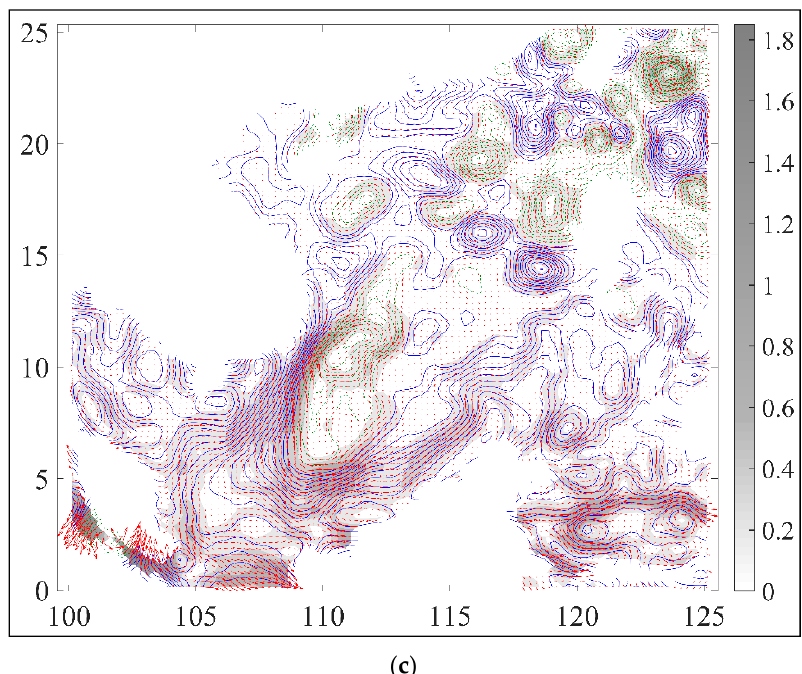
Figure 2. ( a ) Maps to be labeled by experts and the input set of the network. ( b ) The contours of mesoscale features identified by domain experts. ( c ) The visualization of SLA and geostrophic velocity. Color map and contours (black lines) represent the geostrophic velocity speed [m/s] (Equation (1)), and sea level anomaly [cm], respectively.